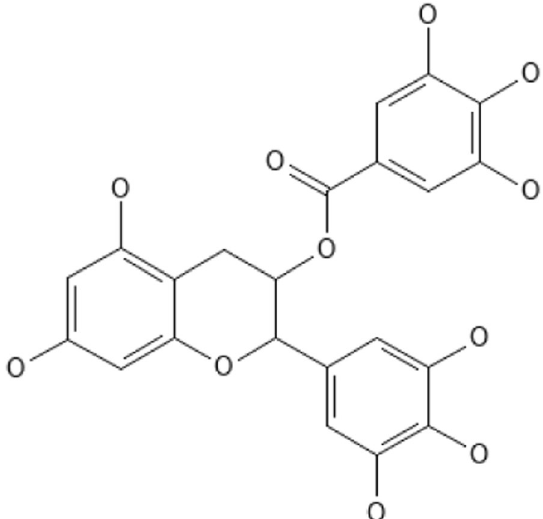
Fig. 2 Structure of Epigallocatechin